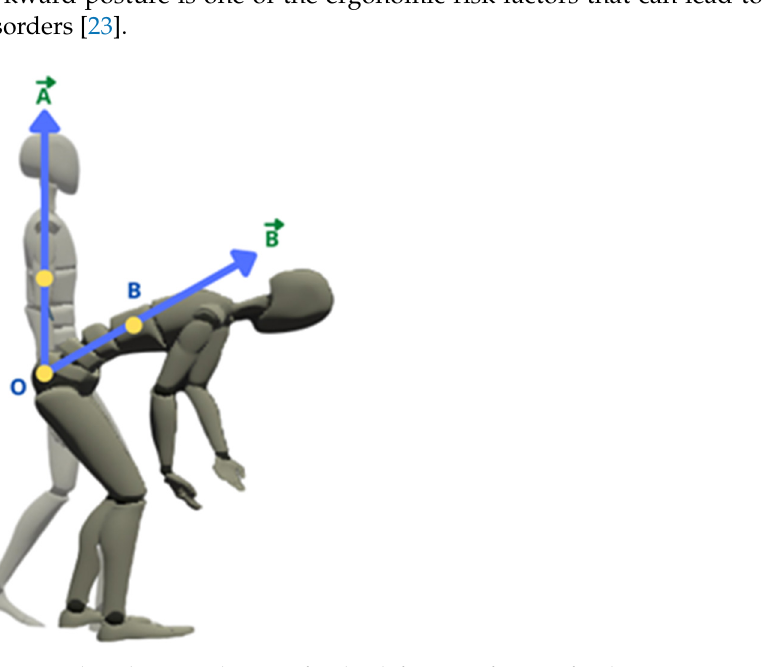
Figure 4. The schematic diagram for the definition of vector for thorax extension. The Rokoko motion capture creates a line of the vector between two respective sensors to calculate the angle of deviation. The unit for the angular acceleration used in this study is the degree (deg). Figure 4 describes the example of a vector line to calculate the angle of deviation. Vector 𝐴⃗ is the stationary position, while vector 𝐵(cid:4652)⃗ is the point during the movement. From the vector 𝐴⃗ and 𝐵(cid:4652)⃗ , the angle deviation is calculated using the arctangent trigonometric function as shown in Equations (2)–(6).